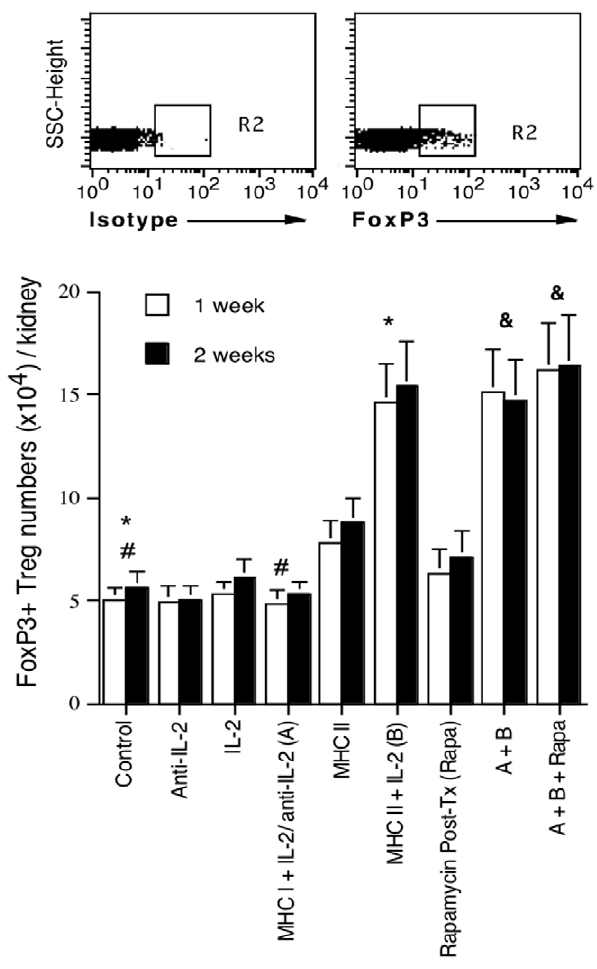
Figure 4. The absolute number of FoxP3-positive Treg cells in allografts. Prior to transplantation, B6 mice were immunized with donor MHC DNA vaccines and/or treated with IL-2 regimen as described in Figure 1. One and two weeks after receiving Balb/C islets under the kidney capsule, recipient mice were sacrificed and graft-infiltrating cells were isolated and stained for FoxP3 to quantify FoxP3 + Treg cells by FACS. FoxP3 + cell numbers were calculated by the formula that total cell numbers per kidney time the percentage of FoxP3 + cells (%). Results are shown as mean 6 SEM from four independent experiments (*P , 0.05, # P . 0.05, and & P .